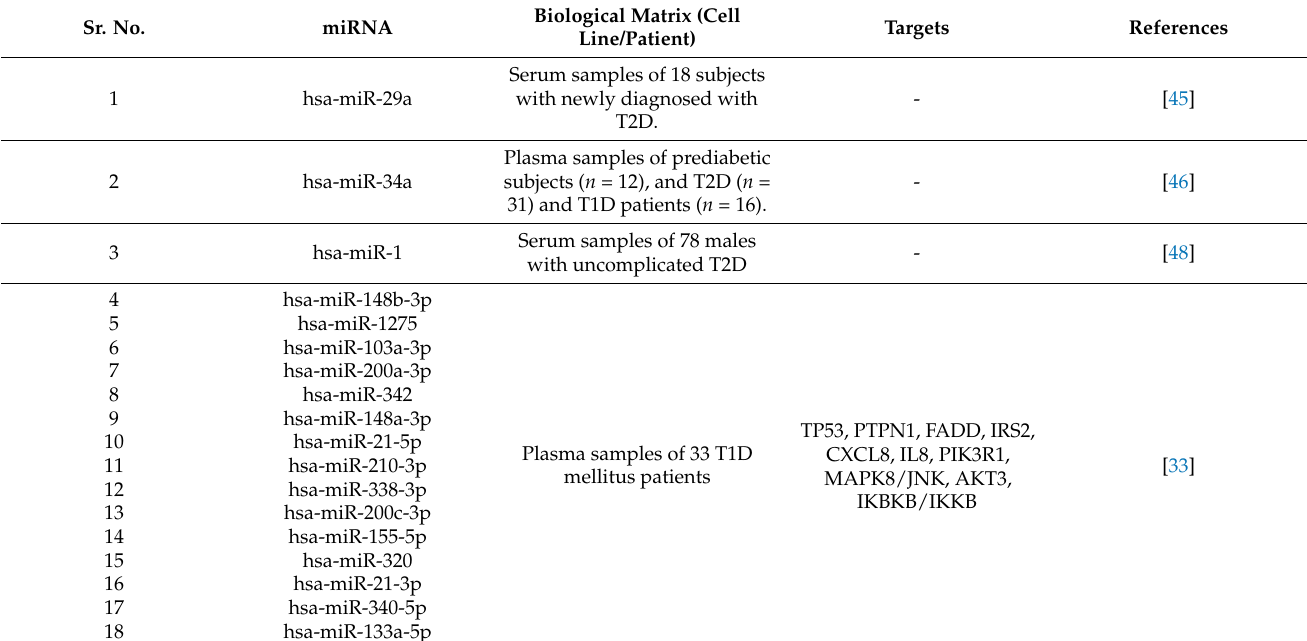
Table 1. Upregulated human microRNAs in